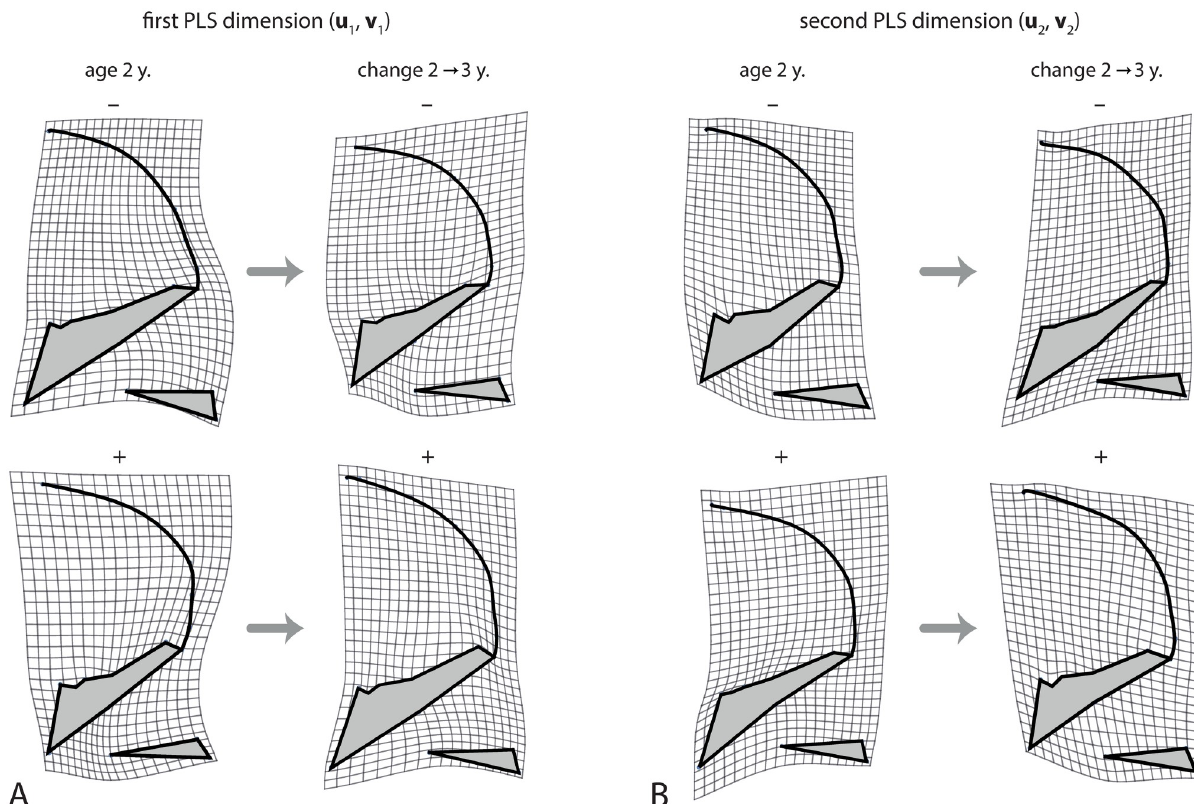
Fig 8. Canalized shape features. Canalization of craniofacial shape from 2 to 3 years of age was explored by two-block partial least squares (PLS) analysis between the shape variables at age 2 (first block) and the shape changes from age 2 to 3 years (second block). (A) The first PLS dimension represents the shape pattern with the largest canalized variance. Individuals with a relatively large pharynx due to a retroflexed cranial base and a relatively short maxilla at age 2 (low scores along u 1 ) tend to experience increased maxillary growth and basicranial flexion from age 2 to 3 years (low scores along v 1 ). By contrast, individuals with a highly flexed cranial base and relatively long maxilla, both of which constrain the pharynx, tend to undergo a more than average increase in pharyngeal size (high scores along u 1 and v 1 ). Note that the left deformation grids represent deviations from the mean shape at age 2, whereas the right grids represent deviations from the mean shape change form 2 to 3 years. Hence, the maxilla does not shrink in individuals with a large maxilla, but it grows less than average. (B) The second PLS dimension represents canalization of facial height: individuals with a relatively high face (inferiorly placed maxilla) undergo reduced facial growth, whereas individuals with a relatively low face (including a small pharynx and nasal cavity) show a more than average increase in facial height. Together, this indicates strong canalization of the relative size of the upper airways in early postnatal